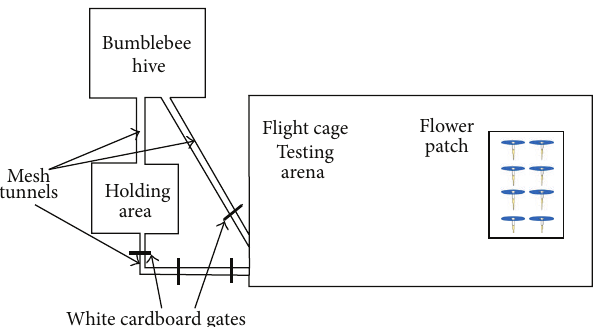
Figure 1: Experiment setup with hive, holding area, flight cage, testing arena, patch of artificial flowers, and mesh tube routes with gates by which the bees were allowed to enter and exit the flight cage. The bees, in training or trained, exited from the hive and could take only one route through the holding area to the testing arena in the main flight cage. The exiting bees were not allowed to use the diagonal route because the gate in it was kept closed. The gates after the holding area were opened and closed to allow single bees to enter the testing arena during testing. The bees returned to their hive from the testing area via the diagonal mesh tube route, the gate of which was opened as necessary. Note that the main flight cage’s end wall, through which the mesh tunnels ran, was a wooden panel so that the bees in the tunnels or in the holding area could not see the flower patch.